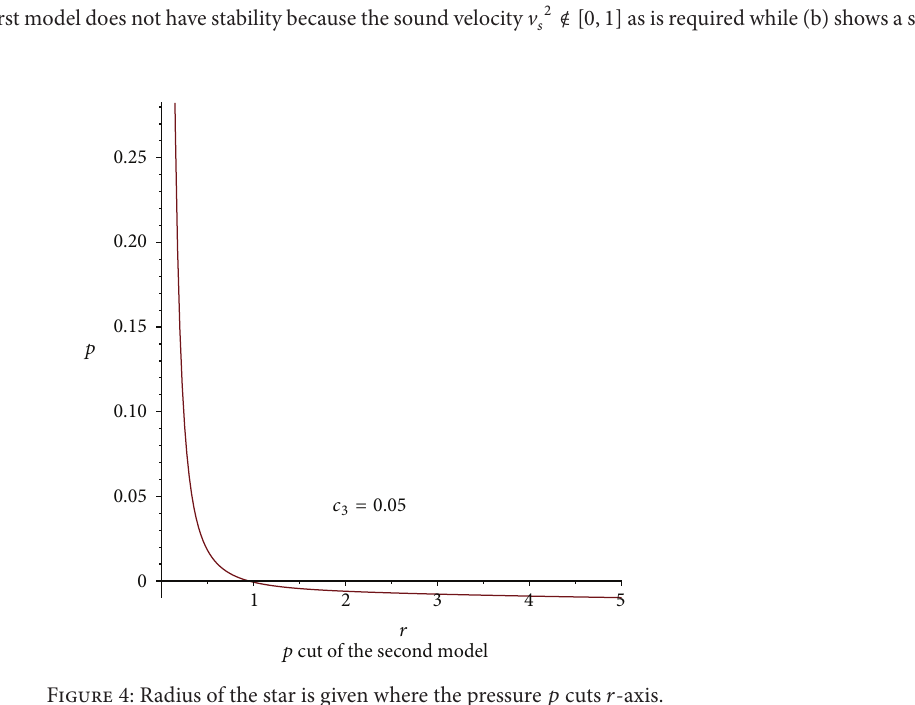
Figure 4: Radius of the star is given where the pressure 𝑝 cuts 𝑟